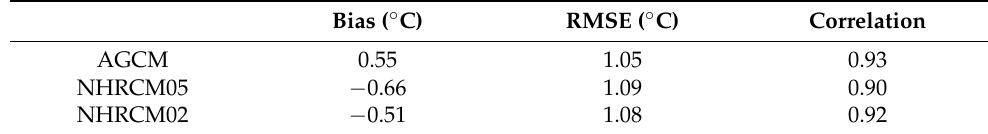
Table 2. Quantitative evaluation of 20-year mean annual surface air temperature averaged over Panama in three simulations against observation. See Figure 2 for geographic evaluation.